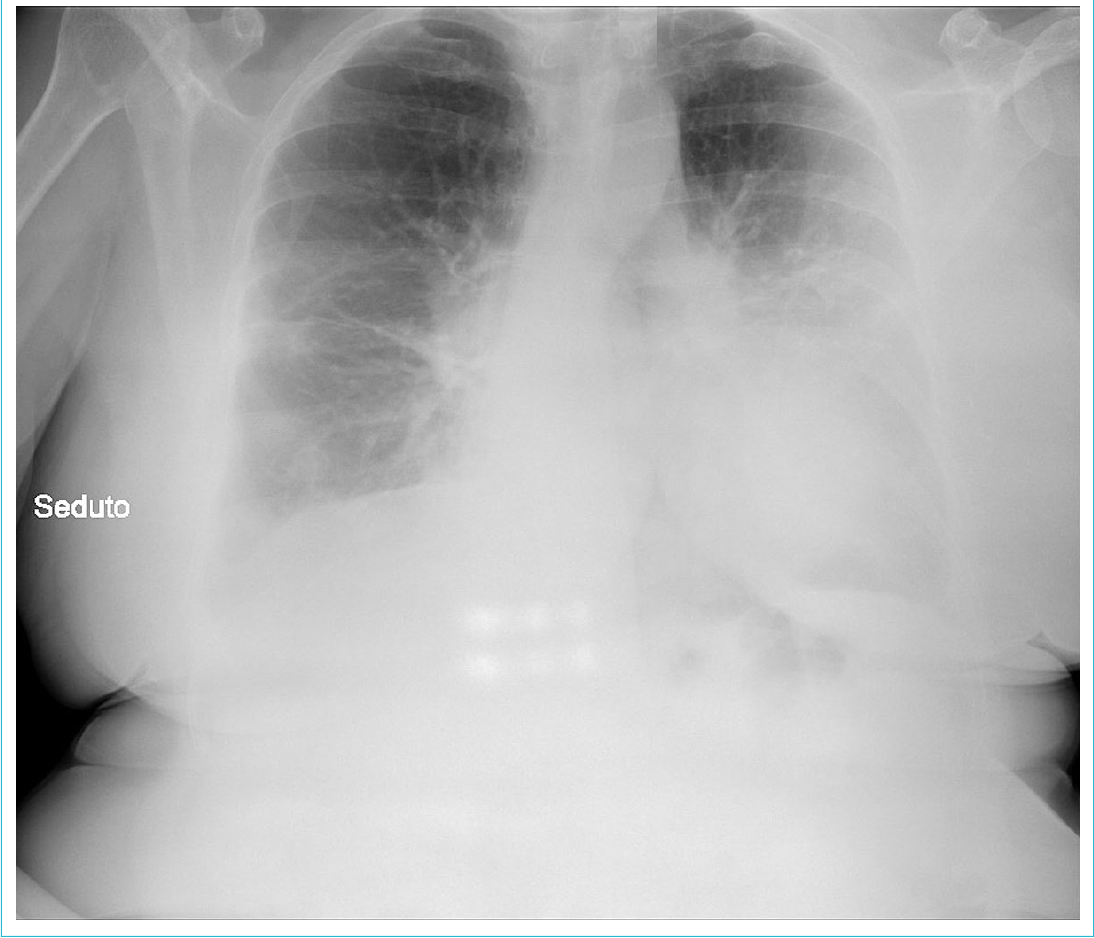
Figure 1: Chest x-ray of patient 1 on admission, 10 March 2020. Courtesy Ospedale di Sassuolo. In addition to the morphological abnormali- ties due to the past medical history of the patient and the more recent alterations described in the CT scans performed on 20 February